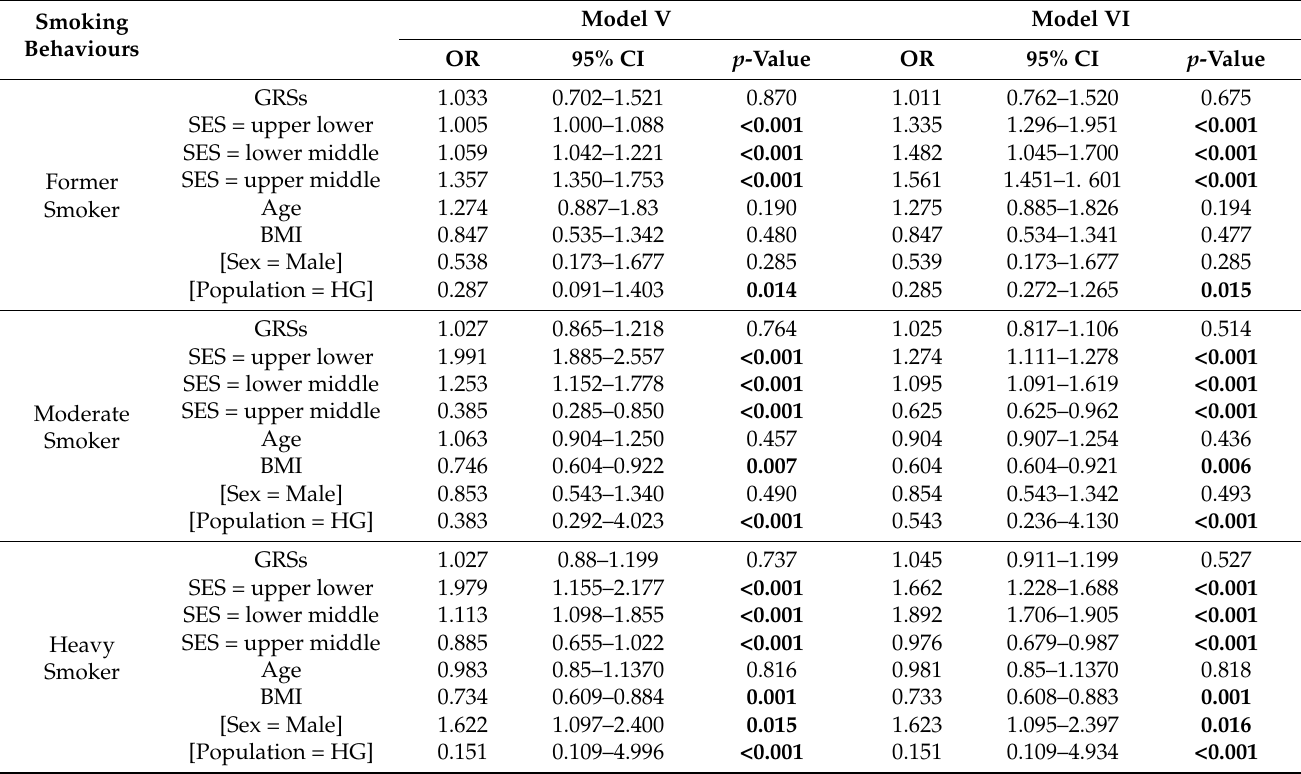
Table 4. Association of smoking behaviours with SES and other